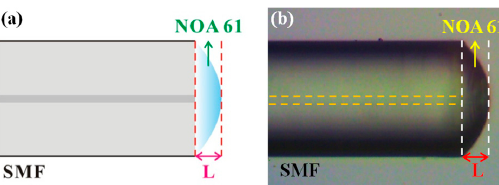
Figure 1. Polymer microcavity fiber Fizeau interferometer (PMCFFI): ( a ) schematic diagram; ( b ) actual photo.